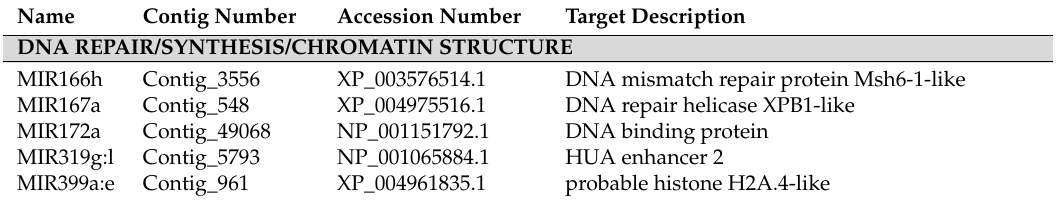
Figure S3: Gene Ontology of overrepresented GO terms associated with the targets of down-regulated miRNAs, Figure S4: Gene Ontology of overrepresented GO terms associated with the targets of up-regulated miRNAs, Figure S5: Representative Electrophoresis assay image of total RNA used for high-throughput sequencing. RNA with RNA Integrity Number (RIN) above 7.5 was used for sequencing library preparation, Table S1: List of conserved miRNAs identified in Tripogon loliiformis , Table S2: List of differential expressed conserved miRNAs in shoots and roots during dehydration, Table S3: List of predicted miRNAs targets associated with T. loliiformis